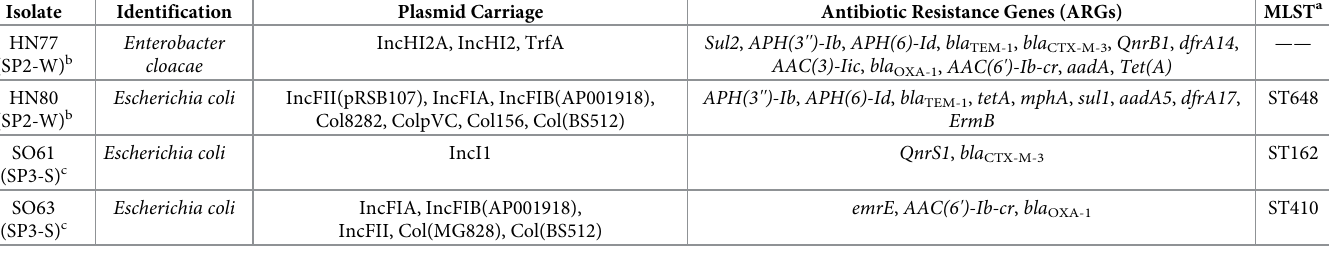
Table 3. Whole genome sequencing (WGS) data obtained from the four multi-resistant isolates scored positive for bla CTX-M in PCR and obtained from the La Paz River